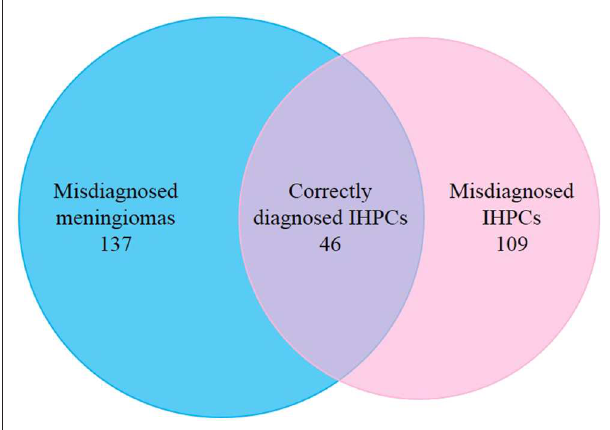
FIGURE 1 | Distribution of enrolled patients. Left circle represents cases of radiologically diagnosed IHPCs; right circle represents cases of pathologically diagnosed IHPCs. Intersection (purple) of two circles represents 46 cases of enrolled IHPCs, which were correctly diagnosed by radiology; 137 cases of pathologically diagnosed meningiomas were radiologically misdiagnosed as IHPCs (blue); 109 cases of pathological diagnosed IHPCs were radiologically misdiagnosed as meningiomas